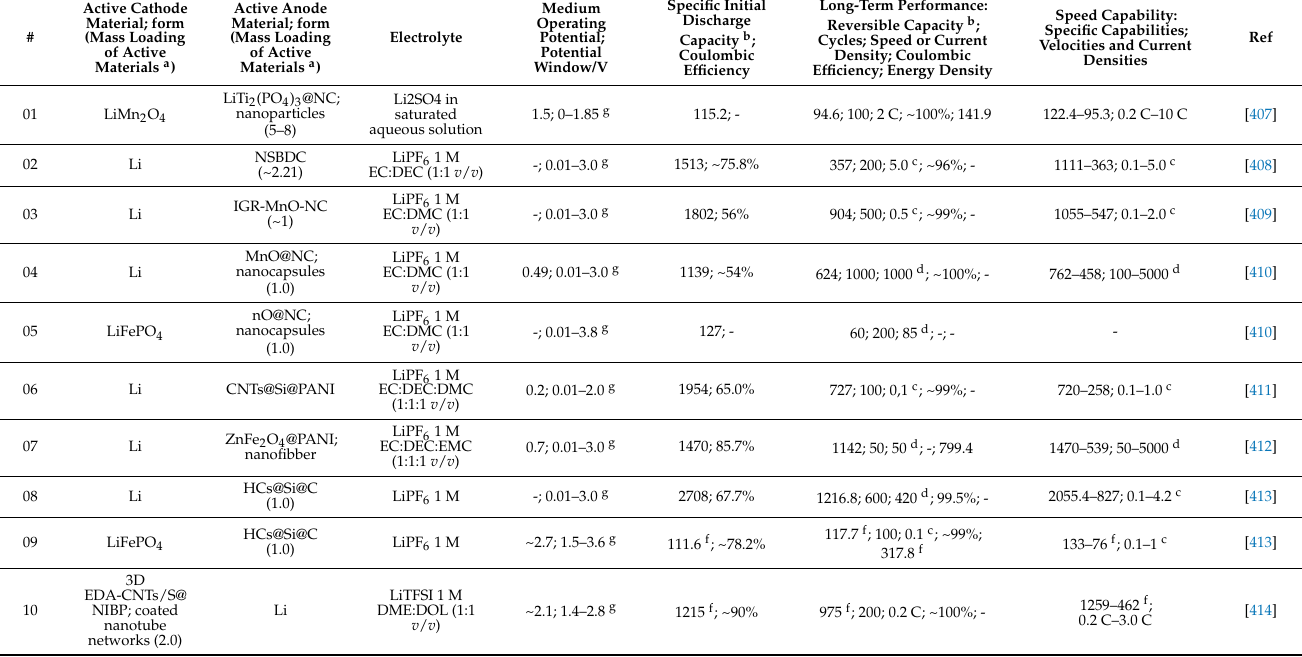
Table 6. Nanostructured NIBP in various configurations, evaluated for rechargeable battery elec- trodes, with their performance